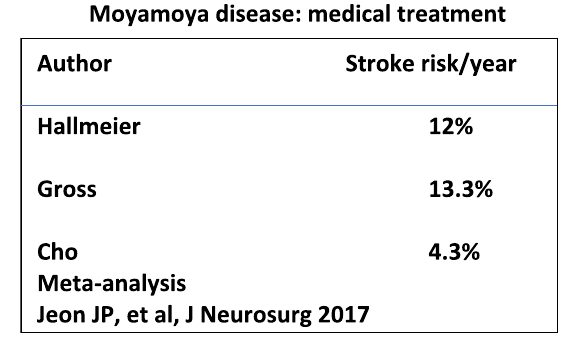
Fig. 1 Causes of paediatric strokes Fig. 3 Moyamoya disease: medical